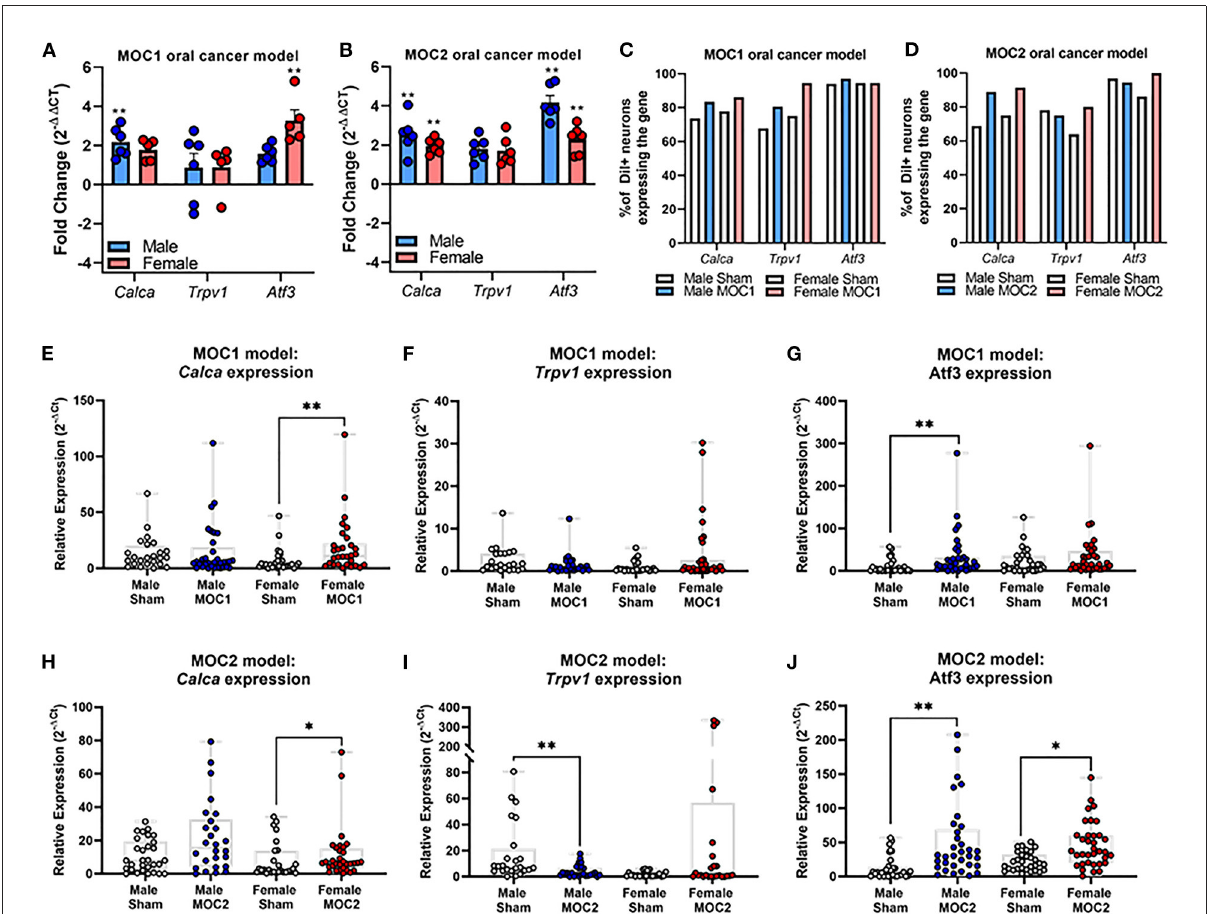
FIGURE3 Oral cancer-induced changes in pain-related gene expression. Quantitative PCR was performed to assess changes in Trpv1 , Calca , and Atf3 in whole ganglia from (A) sham and MOC1 tumor-bearing mice at PID40 as well as (B) sham and MOC2 tumor-bearing mice at PID14. Gapdh was used as an internal control. Significance was determined by comparing delta CT values between treatment groups within sexes ( n = 5–6/sex/group, Independent t-test, ** p < 0.01). To assess changes in target genes at the single cell level, retrogradely labeled tongue-innervating TG neurons were manually picked to perform single-cell PCR ( n = 36 neurons from 3 mice/sex/treatment). Gene expression was calculated for relative mRNA expression in each cell for each gene. GusB was used as an internal control. The percentage of neurons expressing the target genes was calculated for (C) sham and MOC1 tumor-bearing mice at PID40 as well as (D) sham and MOC2 tumor-bearing mice at PID14. (E–J) Relative mRNA expression values from single-cell PCR for each gene are presented as max to min with all points shown. Expression intensities for each gene between groups was compared using non-parametric Kruskal-Wallis with Bonferroni post hoc test. * p < 0.05, ** p < 0.01.